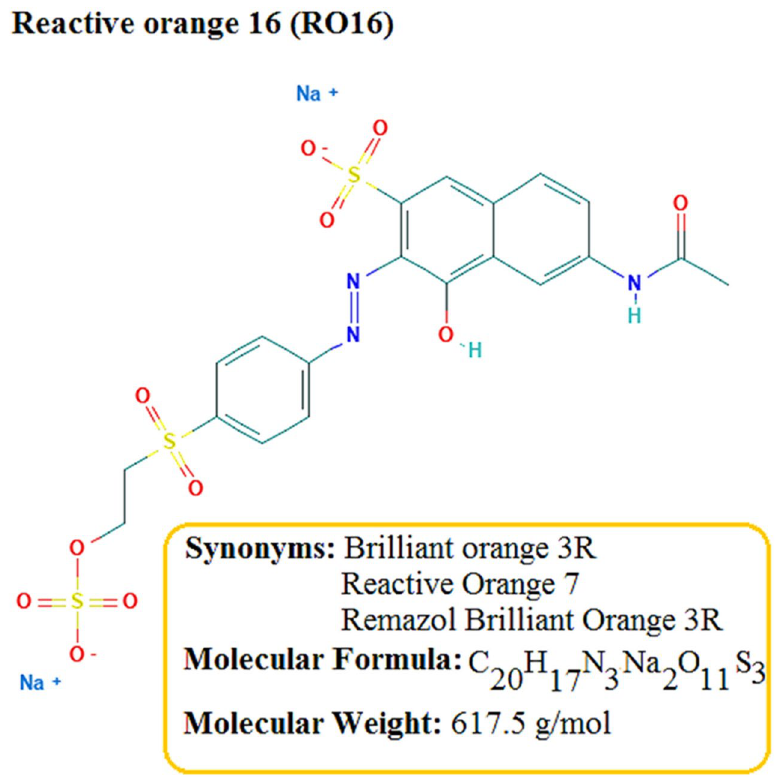
Figure 2. Structure and properties of RO16 dye.